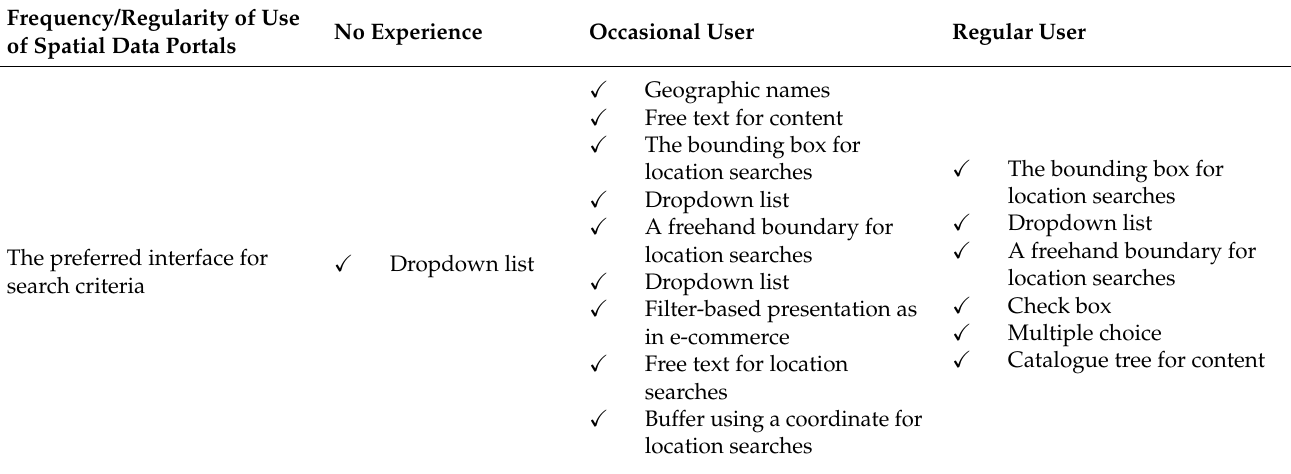
Table 8. User interface preferences for the search criteria.